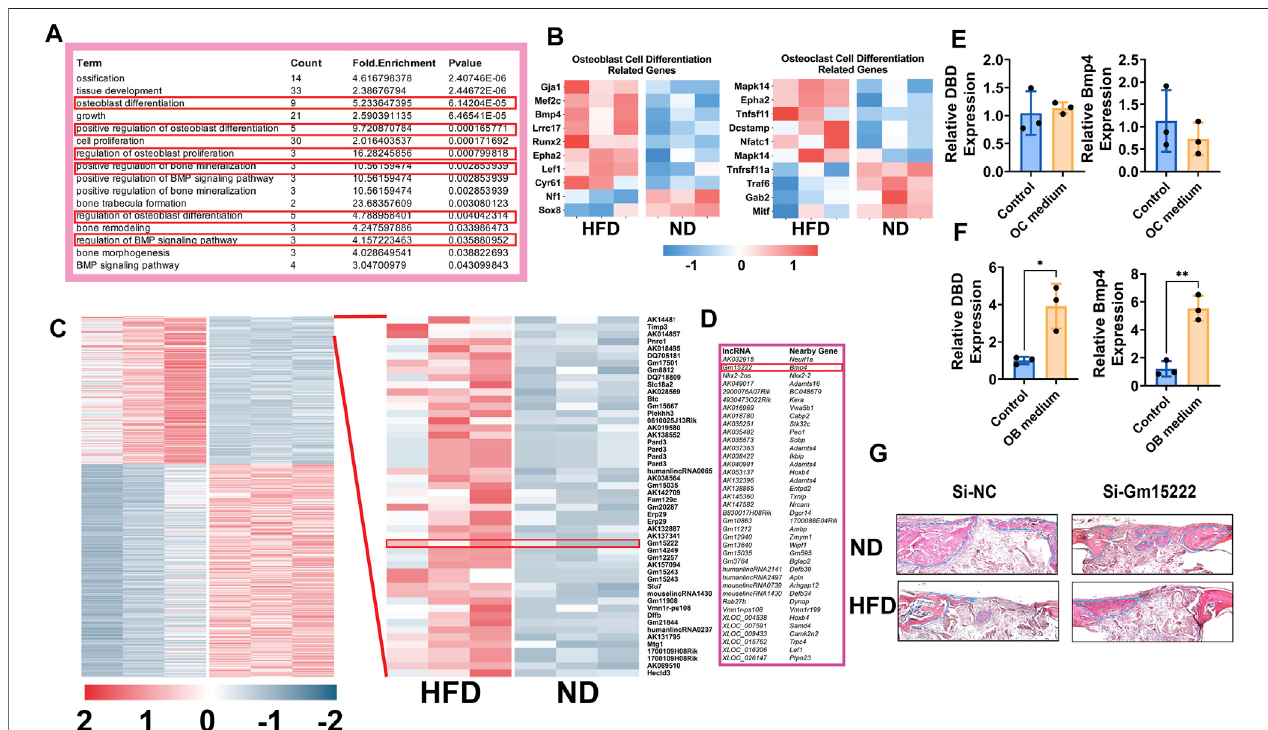
FIGURE 2 | Identi fi cation of Gm15222 which has a distinct function in bone regeneration in the HFD mouse bones. (A) Upregulated genes annotated to a gene ontology (GO) term and example genes by gene ontology enrichment analysis of each component for ND mice and HFD mice. (B) Relative gene expression of osteogenesis (left) and osteoclastogenesis (right) markers ND and HFD mice. (C) The cluster heat map shows differentially expressed genes with expression change of more than two-fold from microarray data (three biological replicates per group, p < 0.05). Selected lncRNA has been highlighted in the red box. (D) lncRNAs classi fi cationand subgroup analysisshowedthesigni fi cantlyexpressed lncRNAs andtheirsigni fi cantlyexpressed nearbygenes. (E) BMMsweretreatedwithorwithout osteoclasts differentiation medium [M-CSF (10 ng/ml) and RANKL (50 ng/ml)] for 5 days. The relative expression of Gm15222 and its related gene, Bmp4, were examined, n = 3. (F) BMSCs were treated with or without a mineralization medium [OM, ascorbic acid (50 μ g/ml), 5 mM β -glycerophosphate] for 5 days, the relative expression ofGm15222anditsrelatedgeneBmp4wereexamined, n =3. (G) Gm15222de fi ciencyinhibitsboneregenerationincranialboneofwild-type(WT)miceand high-fat-diet (HFD) mice. New bone was shown and highlighted with blue dotted lines. Data were shown as mean ± S.D., two-tail t -test was used to test for those data between two groups. * p < 0.05; ** p < 0.01; *** p < 0.001; **** p < 0.0001.